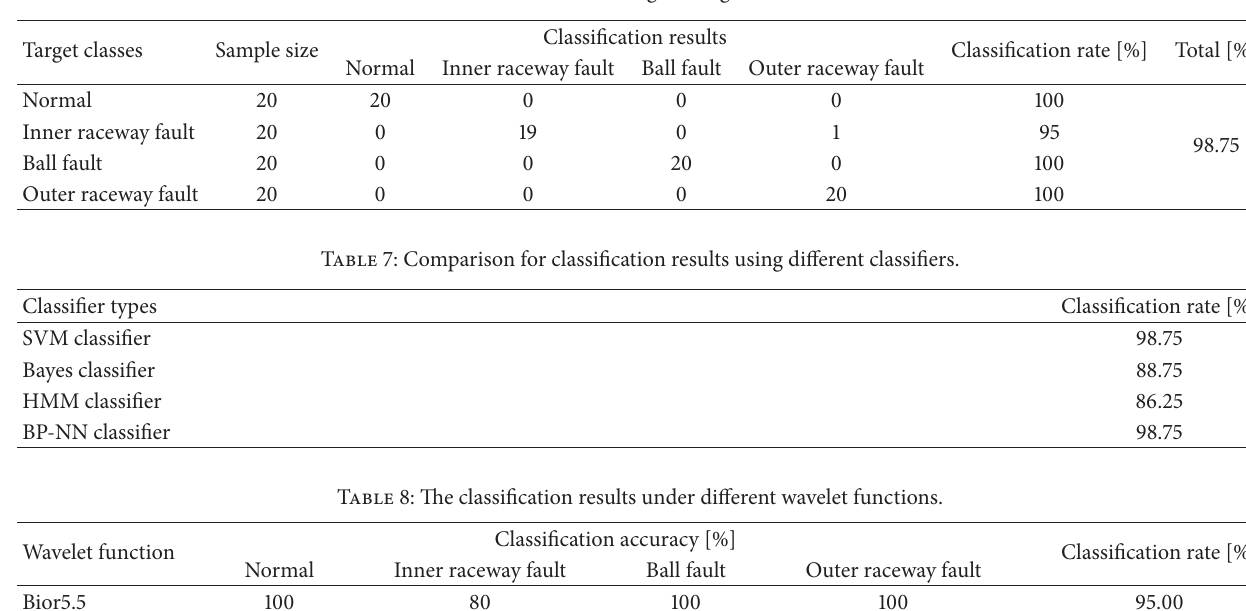
Table 6: Classification results of rolling bearing faults at different locations.